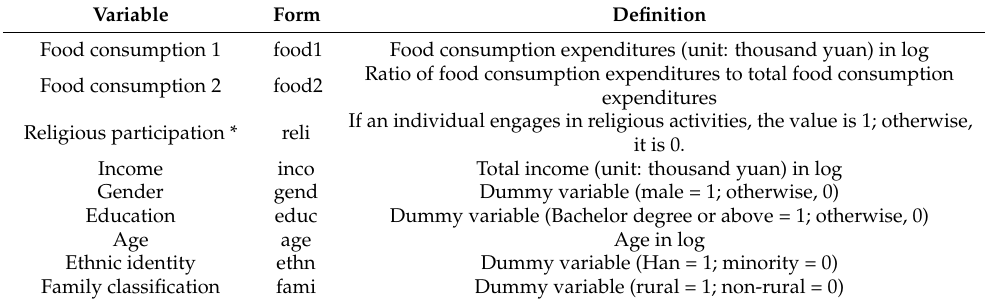
Table 1. Results of variable